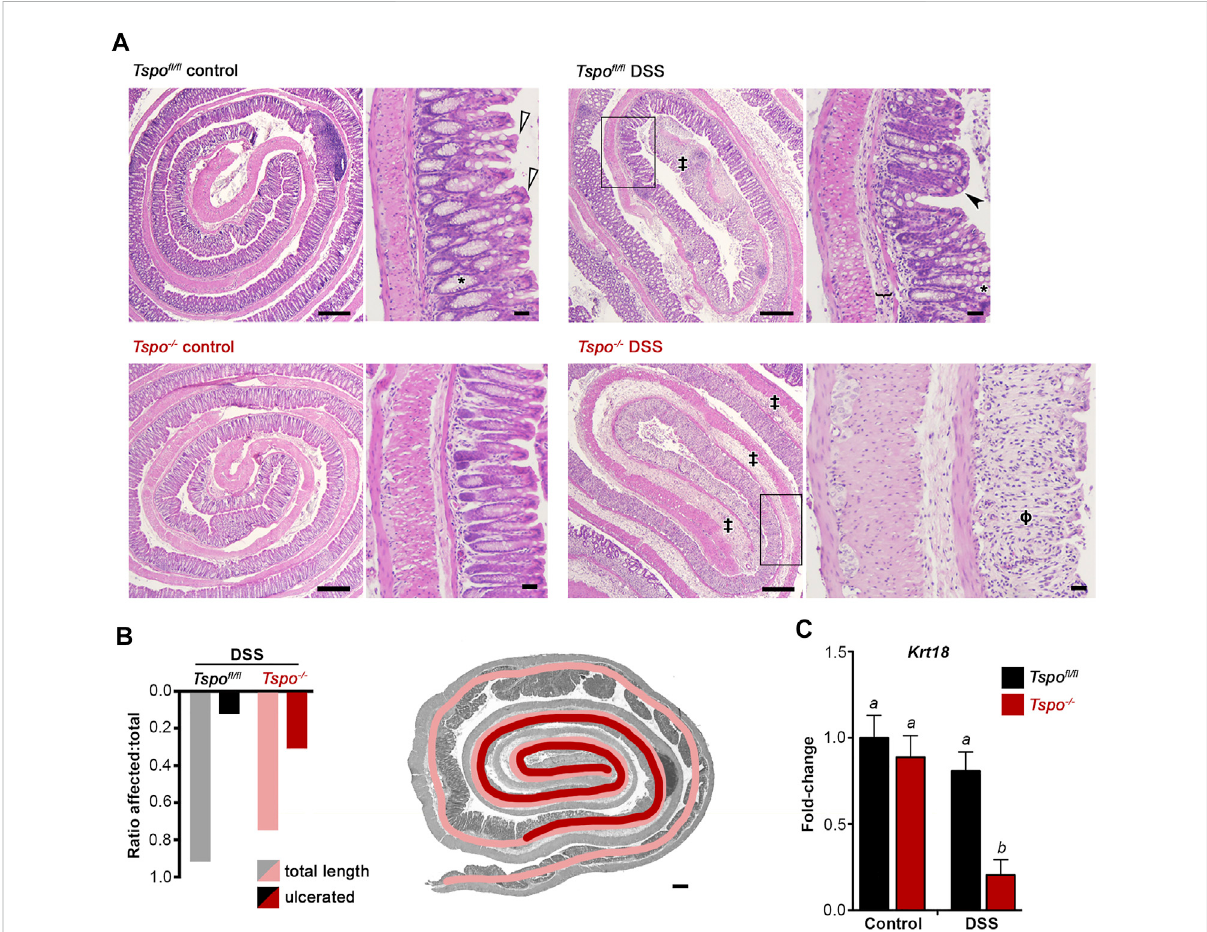
Histopathology and epithelial loss indicate severe in fl ammation with UC in Tspo − / − mice. (A) Histopathological images showing colon rolls (clockwise: inside distal to outside proximal), from control colons and 7-day DSS-induced UC colons. Representative images are shown for both Tspo − / − and Tspo fl / fl colons.Control Tspo − / − and Tspo fl / fl colons werehistologicallyindistinguishable.Normalmorphology consists ofbasally-located gobletcells (*),anarrow submucosa andthinmuscularis mucosa, cuboidal tocolumnarmature absorptive epithelialcells (whitearrowhead). In both UC cohorts, the pathology was most severe at the distal colon, consistent with the pathogenesis of UC. DSS-treated Tspo fl / fl animals exhibited segmental moderate UC,withthedistalcolon demonstrating moderateedema,loss ofcryptandgoblet cells, moderateto severein fl ammation, and erosionandulcerationofthecolonicepithelium( ‡ ).Inthemid-colon(blackbox), Tspo fl / fl colonsshowedlessseverepathology,characterizedbymild submucosal edema (bracket), and mild mononuclear in fl ammation. The mucosa displays shortened, immature epithelial cells (black arrowhead). Partial loss of the colonic crypts is present, as well as goblet cell hyperplasia and altered distribution of goblet cells towards the apex of the crypts. DSS-treated Tspo − / − animals developed more diffuse UC, affecting the entirety of the distal colon and extending into the mid-colon (black box) and proximal colon. These animals exhibited severe, diffuse colonic edema, extensive crypt and goblet cell loss ( ϕ ), muscular hypertrophy, epithelial ulceration and erosion, and severe diffuse mononuclear in fl ammation. (Low magni fi cation scale bar: 300 μ m; high magni fi cation scale bar: 30 µm). (B) In quantitating the regional degree of colonic epithelial ulceration and erosion due to UC, the ratio of affected:total colon length demonstrated signi fi cantly greaterdamagein Tspo − / − colons than Tspo fl / fl colons (0.44vs.0.17 respectively; p =0.0039, Z= 2.885, n =9per group). Representative histopathology image with an overlay of color-coded measurement lines is shown to demonstrate this quanti fi cation of disease extent. (C) Expression of Krt18 , an intestinal epithelial marker, in the distal colon of Tspo − / − and Tspo fl / fl mice at baseline and at day-7 of DSS-induced UC; signi fi cant down-regulation of Krt18 indicative of epithelial loss is observed only with UC in Tspo − / − colons ( n = 7 per group; p =